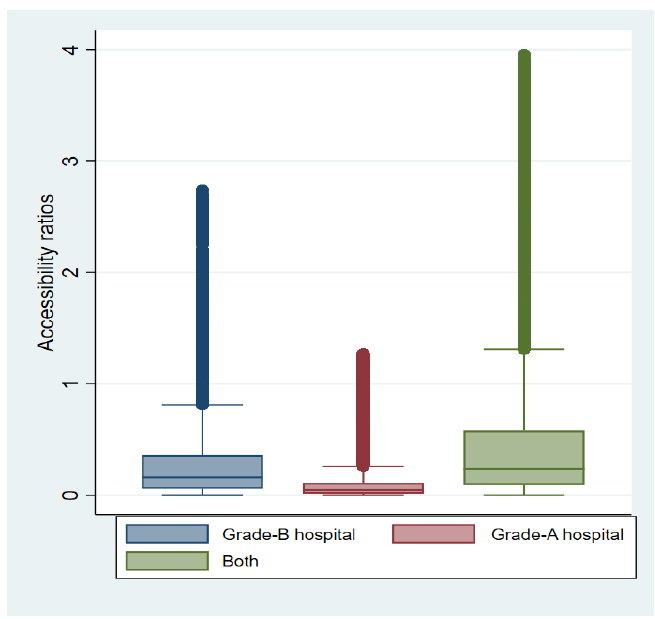
Figure 4. Variation in accessibility ratios of rural residents in Hubei Province.